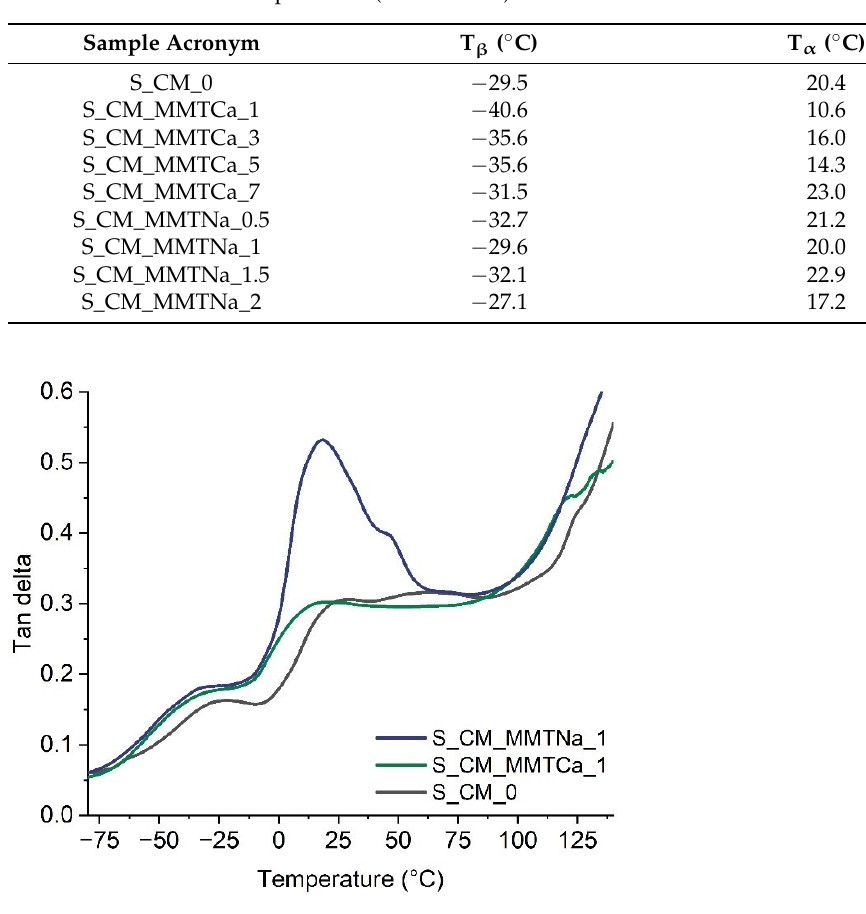
Table 2. The transition temperatures (DMTA tan δ ) of starch films with montmorillonite.